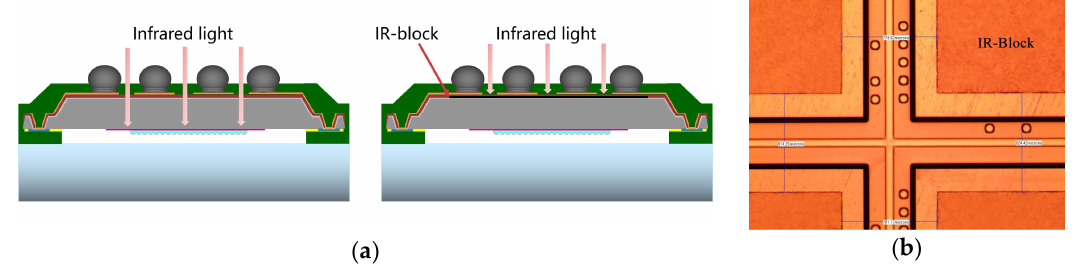
Figure 12. ( a ) Schematic of IR-block; ( b ) OM image of IR-block process.